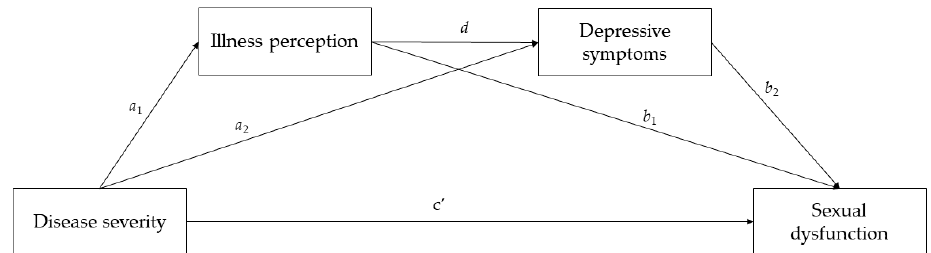
Figure 1. The hypothesized serial multiple mediator model .